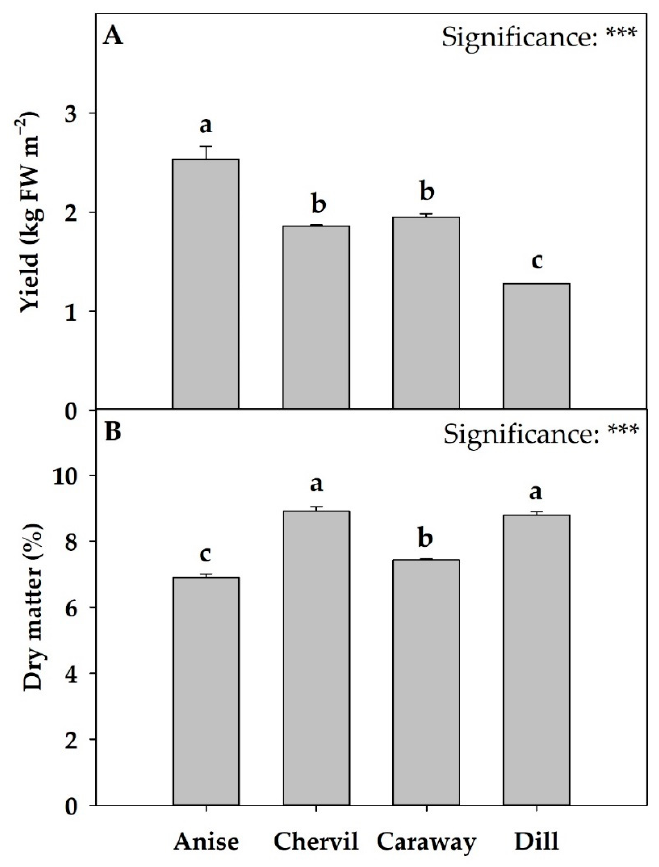
Figure 1. Yield ( A ) and dry matter percentage ( B ) of four Apiaceae microgreens grown under controlled environment. *** indicates the significance at p ≤ 0.001. Significant differences based on Tukey’s HSD test are indicated by different letters placed above each vertical bar ( p = 0.05). All data are expressed as mean ± standard error, n = 3. Pimpinella anisum L.: Anise; Anthriscus cerefolium :